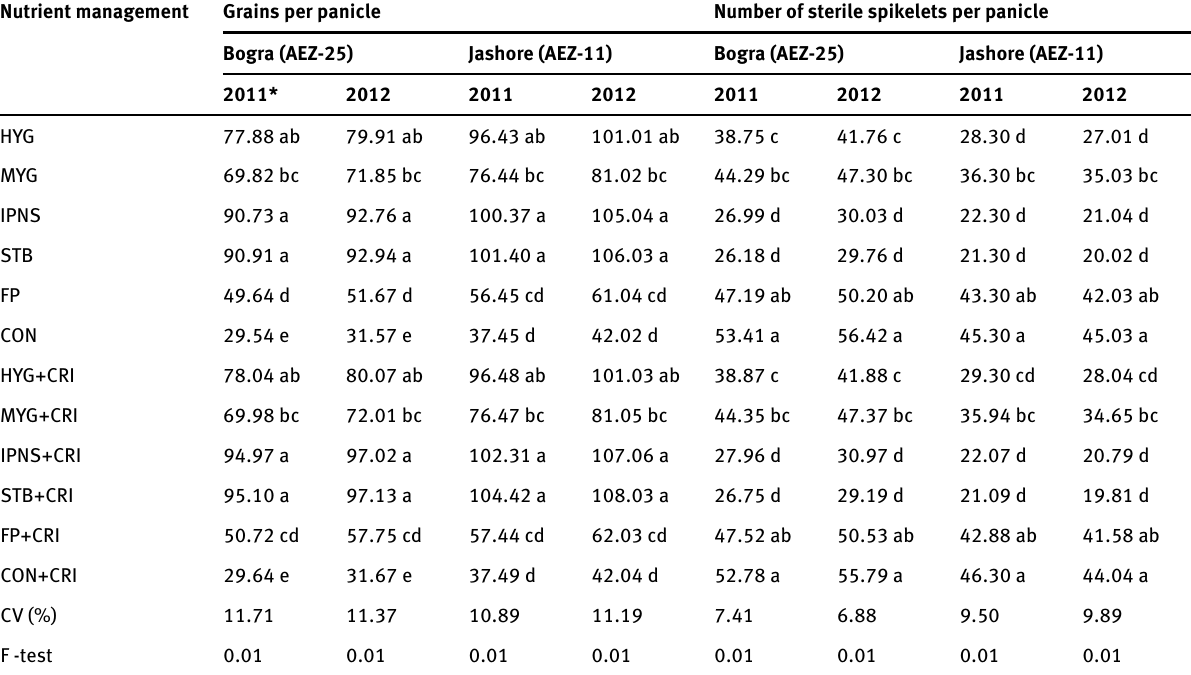
Table 4: Influence of different nutrient management strategies on sterile spikelets per panicle and grains per panicle of rainfed monsoon rice at two locations in Bangladesh Nutrient